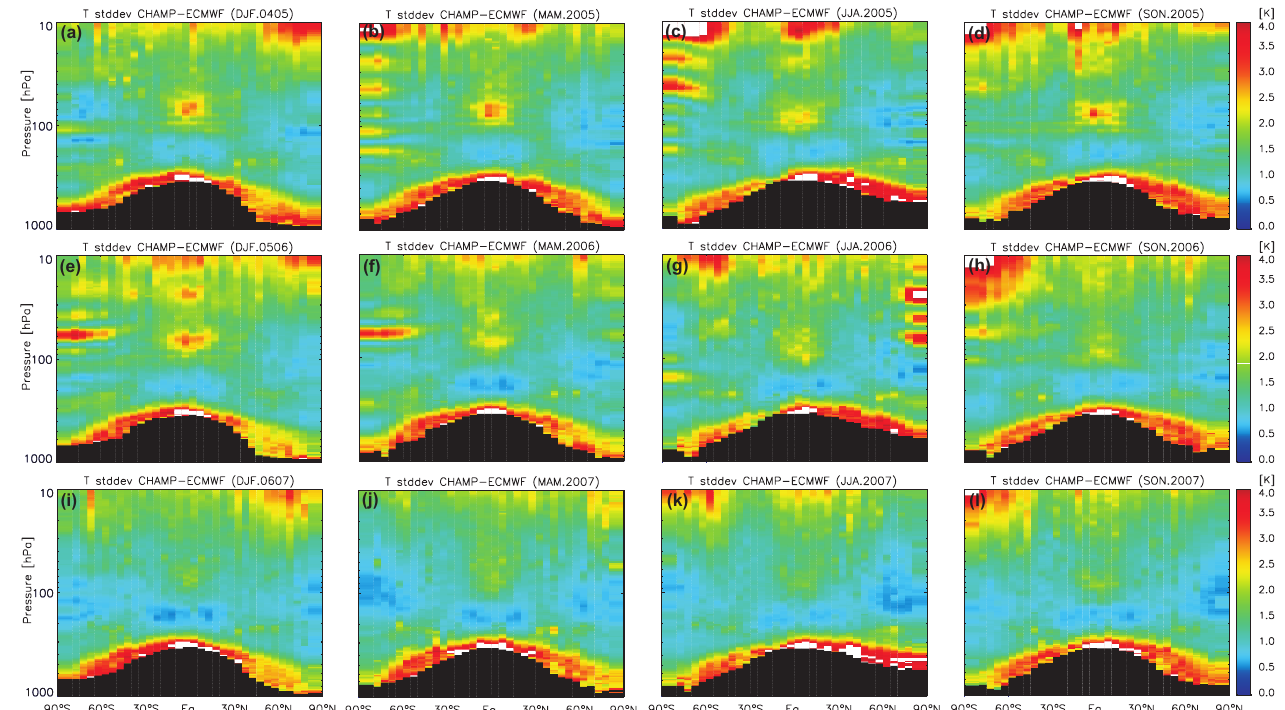
Fig. 8. Same as Fig. 7, but for the stddev. In the white areas the stddev is larger than